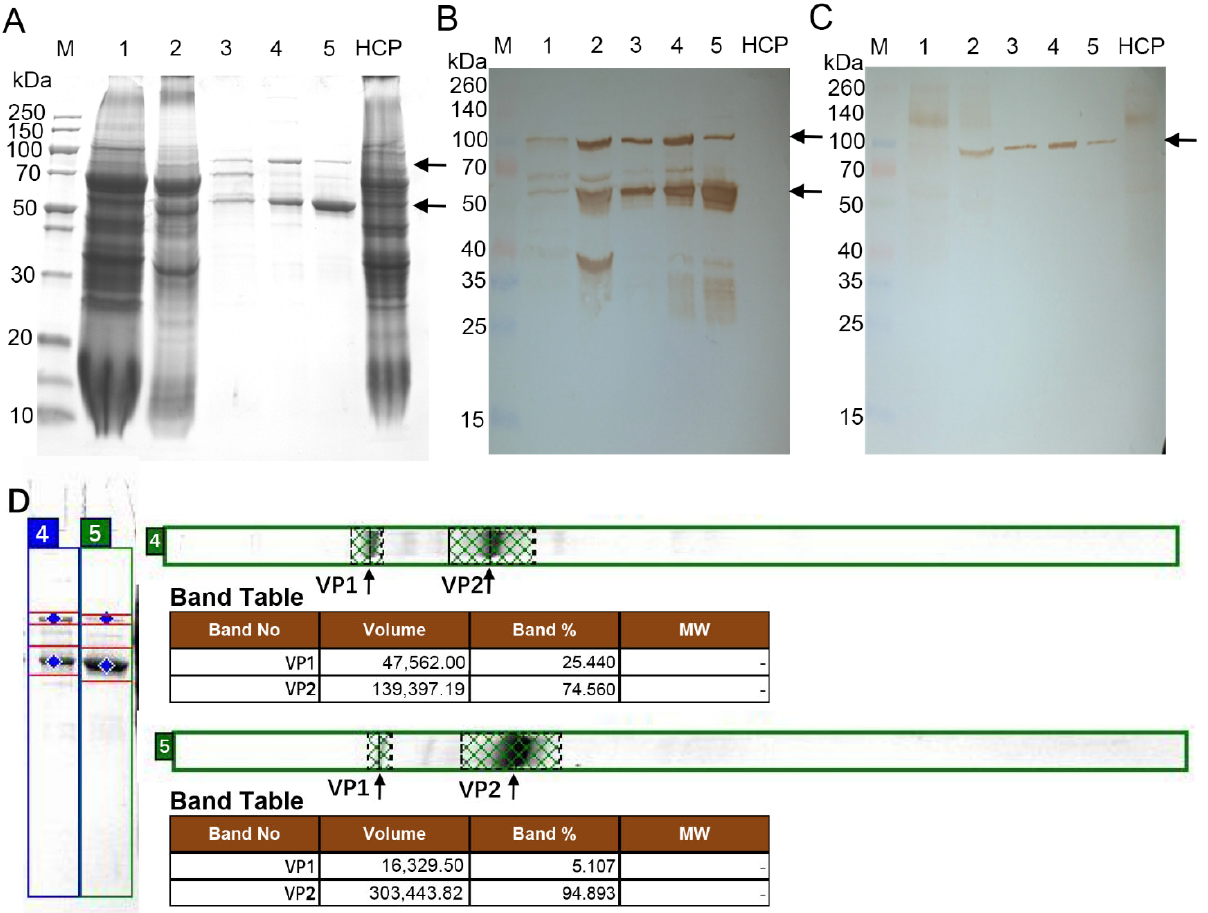
Figure 2. SDS ‐ PAGE and Western blot analysis results of the VP1/VP2 and VP1h/VP2 VLPs recom ‐ binantly expressed by using the Hansenula polymorpha yeast. ( A ): SDS ‐ PAGE of the VP1/VP2 and VP1h/VP2 VLPs. ( B ): Western blot analysis of the VP1/VP2 and VP1h/VP2 VLPs in which the anti ‐ parvovirus B19 5E408 monoclonal antibody was used. ( C ): Western blot analysis of the VP1/VP2 and VP1h/VP2 VLPs in which the anti ‐ VP1u polyclonal antibodies were used. (D): Gray scanning results for the relative contents of VP1 and VP2 in the VP1/VP2 and VP1h/VP2 VLPs by using the ImageQuant TL software. M: marker; Lane 1: whole ‐ cell lysate proteins of the Hansenula polymorpha expressing VP1h/VP2 VLP; Lane 2: VP1h/VP2 VLP sample after crude purification by two ‐ aqueous phase extraction; Lane 3: VP1h/VP2 VLP sample after purification using the gel column chromatog ‐ raphy; Lane 4: VP1h/VP2 VLP after further purification using the anionic ‐ exchange chromatog ‐ raphy; Lane 5: VP1/VP2 VLP after gel column chromatography and anionic ‐ exchange chromatog ‐ raphy purifications; HCP: host cell proteins. The bands corresponding to the VP1 and VP2 proteins were marked by black arrows.